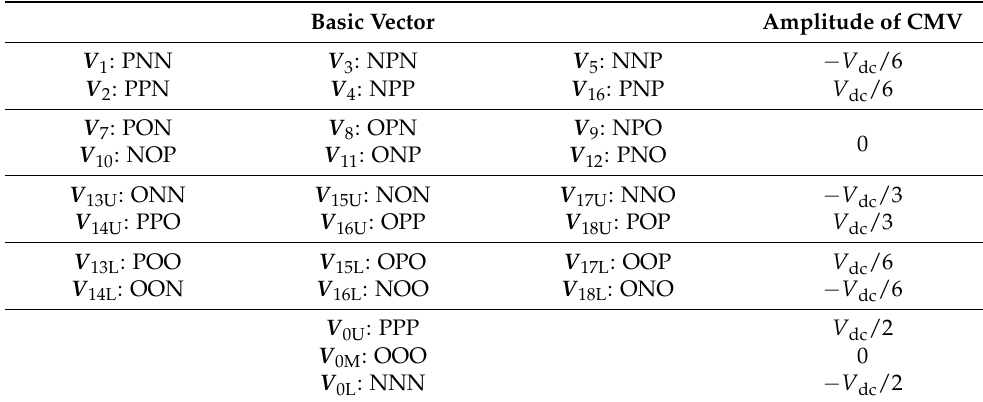
Table 2. Common-mode voltage of each basic